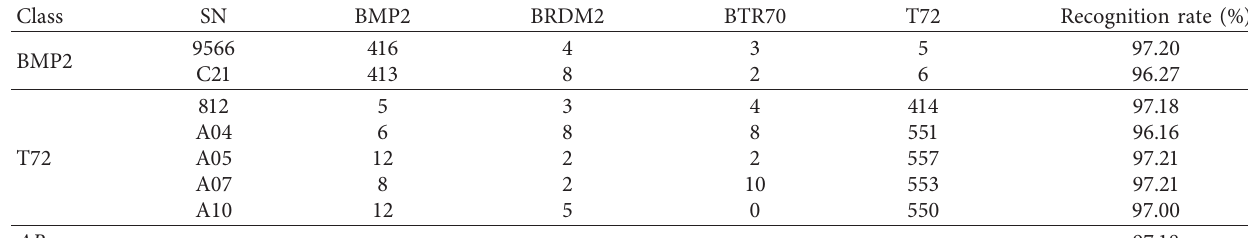
Figure 5: Illustrations of configuration variances in T72. (a) Optical. (b) Table 4: Results of the proposed method under configuration variance.